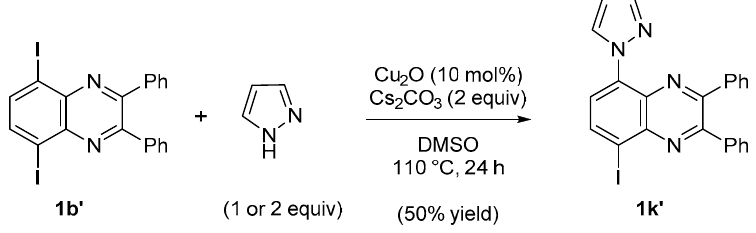
Table 4. Copper-catalyzed N -arylation of 8-iodo-2,3-diphenylpyrido[2,3- b ]pyrazine ( 2b-I ) using azoles.